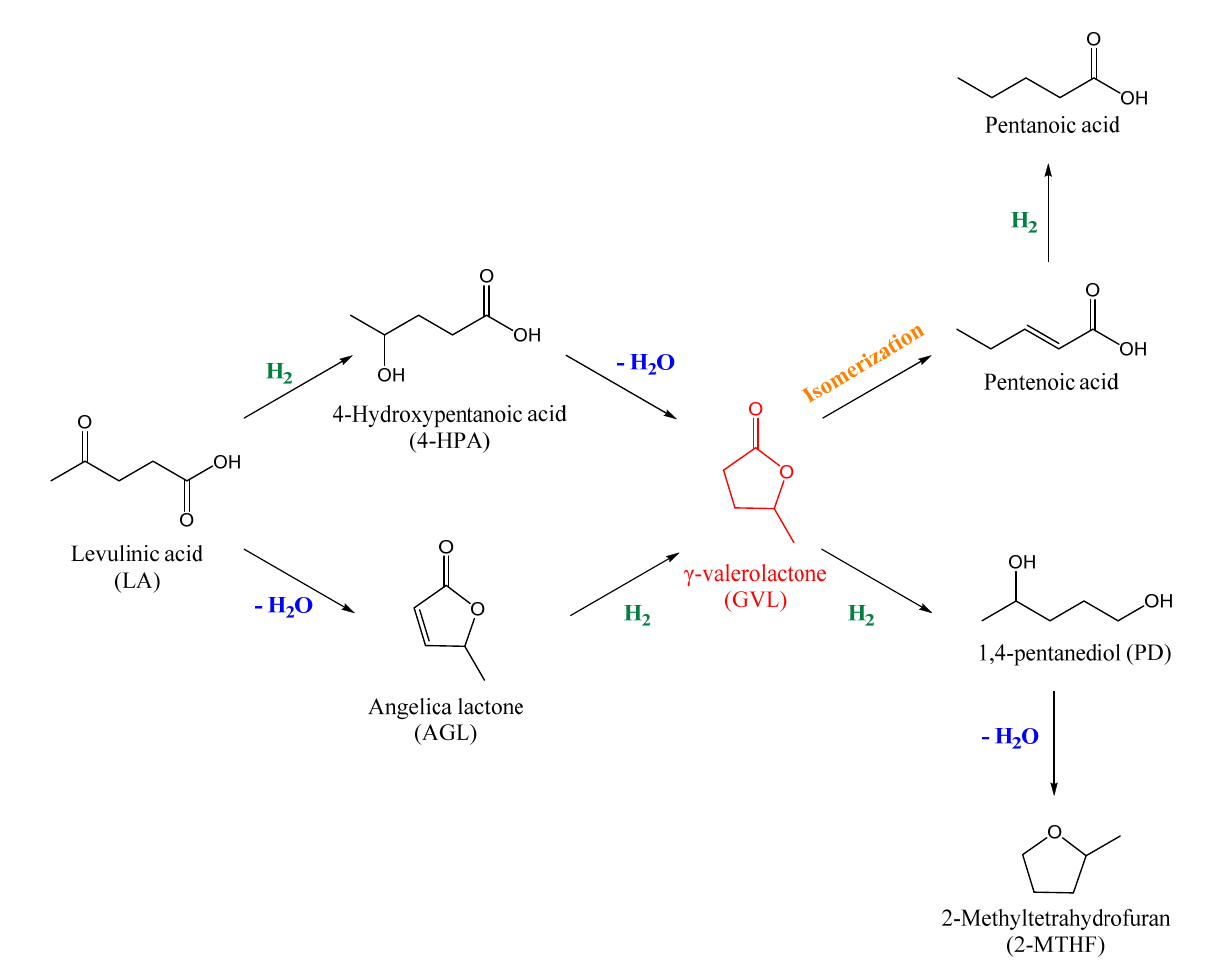
Scheme 1. Different levulinic acid HDO transformation